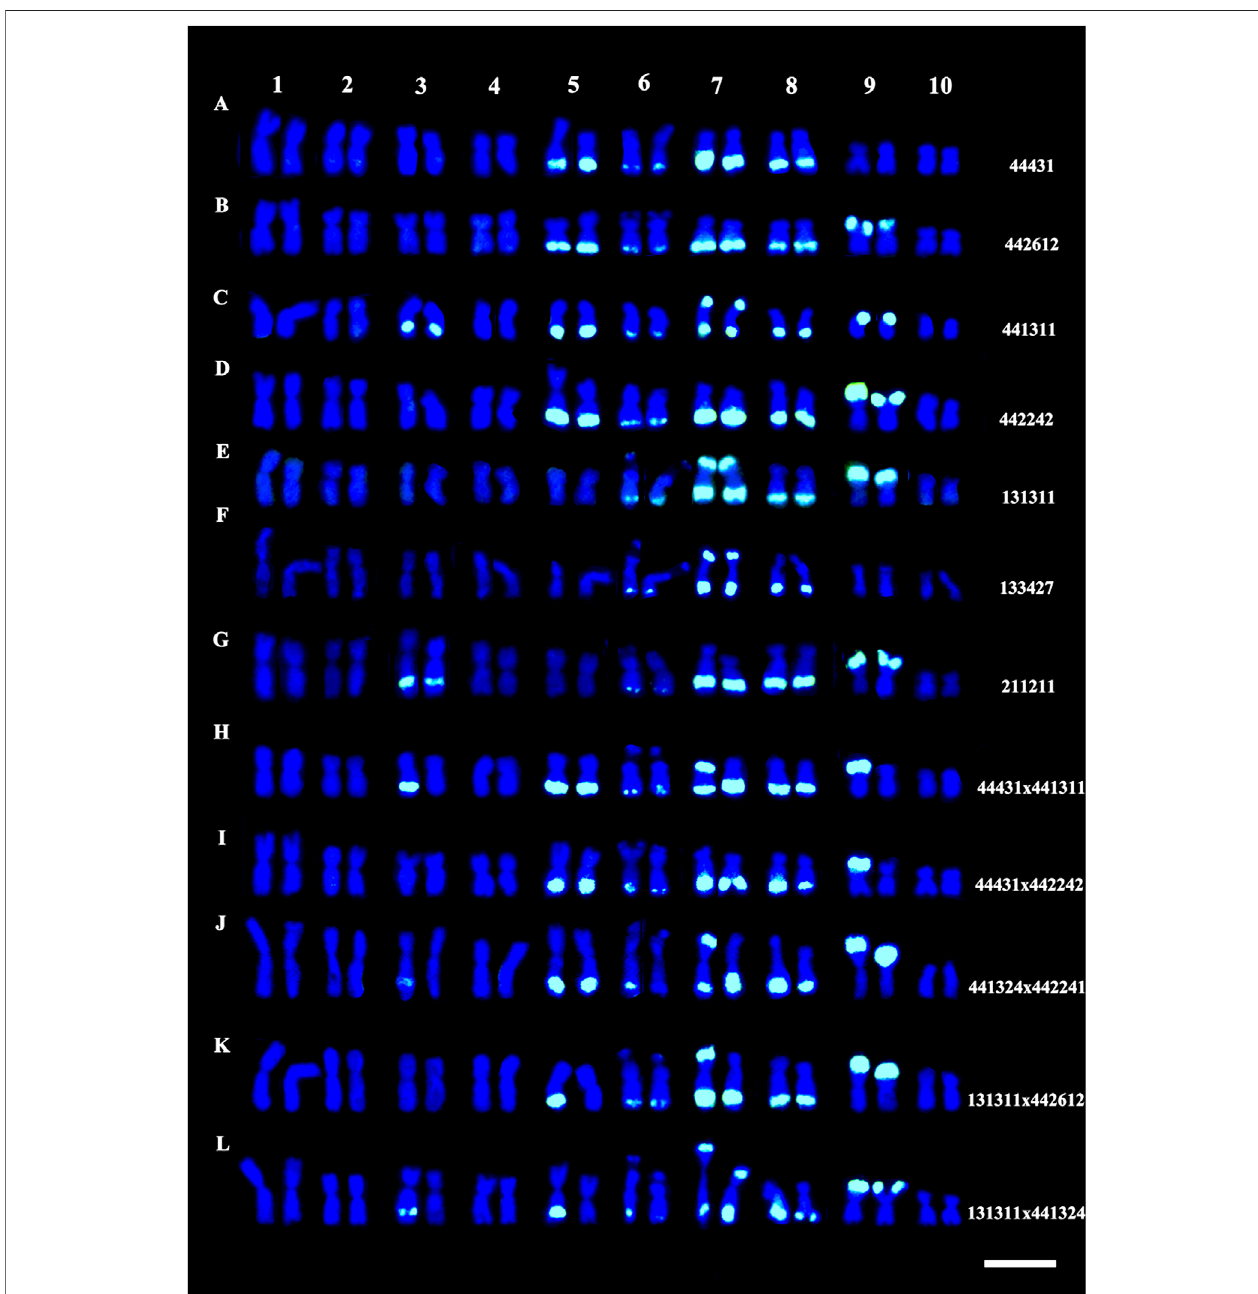
FIGURE2| Asamplingofgenotypesusedintheexperimentson fl oweringtimeandgenomesize. (A – G) SomatickaryotypesofJDlines;and (H – L) hybrids,labeled by FISH using a probe for the knob 180-bp repeat (green). Bar (cid:1) 10 μ m.